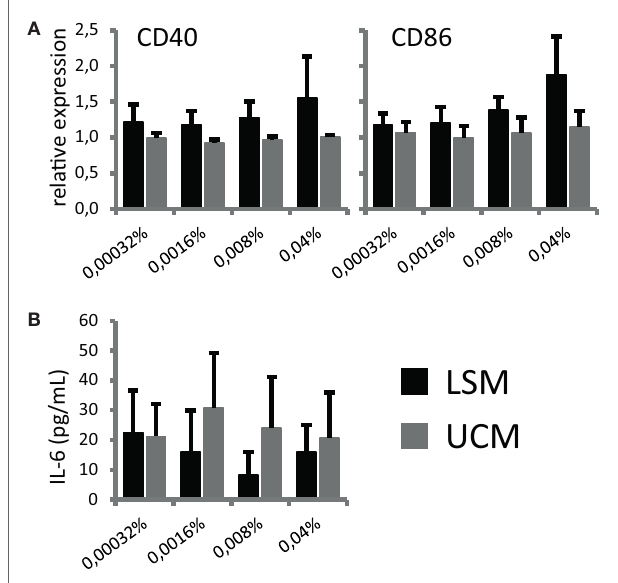
FigUre 2 | LGG soluble mediator (LSM) alters dendritic cells activation. moDC were cultured in the presence of LSM or UCM and subsequently matured by TNF- α . (a) Expression of CD40 and CD86, based on mean fluorescence intensity, on CD11c + cells after overnight TNF- α stimulation relative to expression on control CD11c + cells. (B) Concentration of IL-6 in culture supernatant after overnight TNF- α stimulation was measured by ELISA. Data are presented as the average of at least three independent cultures ±